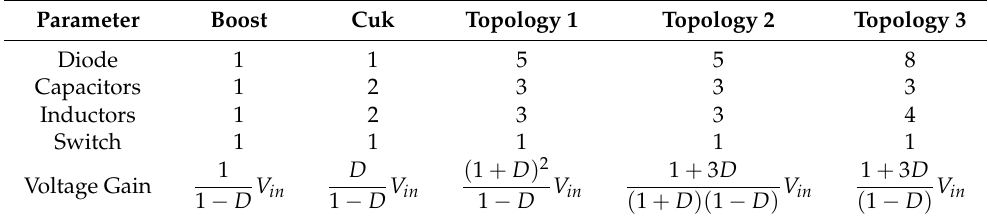
Table 5. Comparison of